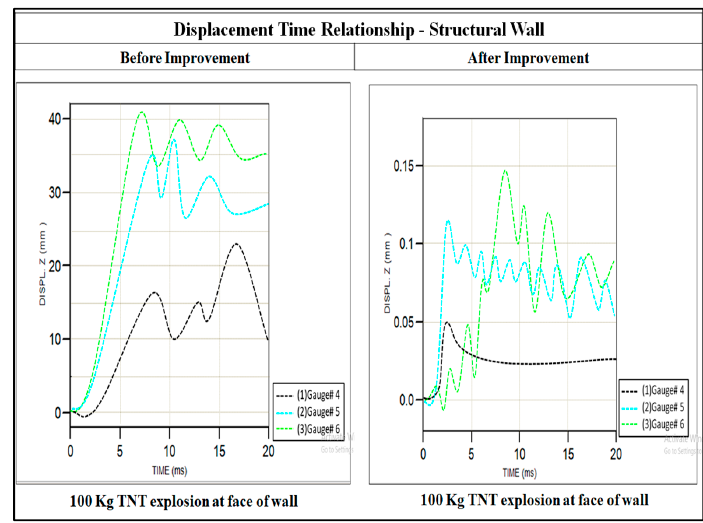
Figure 8. Comparison of TNT explosions at the face of RCC wall panels.